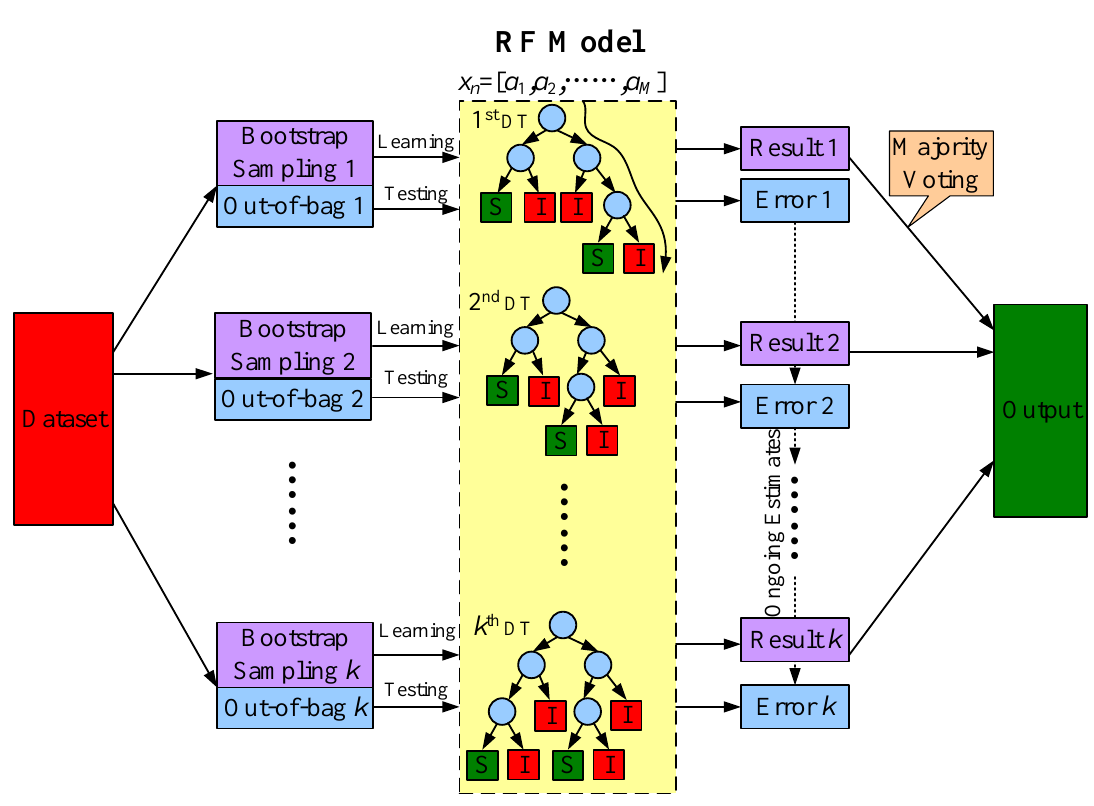
Figure 3. The illustrative structure of a Random Forest model.